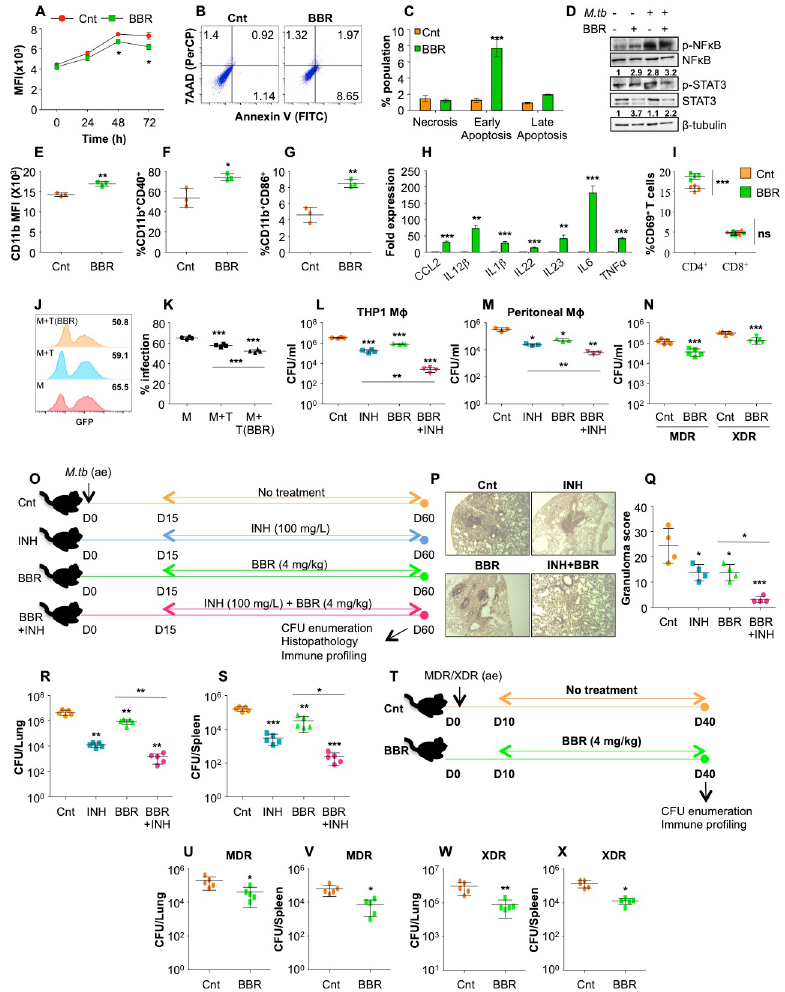
Fig 1. BBR treatment enhances host resistance against drug-sensitive and drug–resistant TB. (A) Mouse peritoneal macrophages were infected with GFP expressing H37Rv (Rv-GFP) at 1:10 MOI followed by treatment with BBR (20 μ g/ml). At different time points, cells were analysed by flow cytometry. Graph represents the GFP fluorescence at indicated time points with and without BBR treatment. (B-C) Mouse peritoneal macrophages were infected with M . tb at MOI of 1:10 followed by treatment with BBR (20 μ g/ml) for 48 h followed by apoptosis analysis via flow cytometry. (B) Representative dot plots and (C) Percentage of apoptotic cells with and without BBR (20 μ g/ml) treatment. (D) Immunoblots depicting the phosphorylation of indicated transcription factors (NFkB and STAT3) in uninfected and infected mouse peritoneal macrophages with or without BBR treatment. (E-G) Infected murine peritoneal macrophages were surface stained with antibodies against CD11b (APC/Cy7), CD40 (PE) and CD86 (PerCPCy5.5) followed by flow cytometry. (E) Expression of CD11b on the surface of infected macrophages. Percentage of (F) CD11b + CD40 + and (G) CD11b + CD86 + infected macrophages with and without BBR treatment. (H) Expression of chemokines and cytokines in M . tb infected macrophages at 24h pi with and without BBR (20 μ g/ml) treatment. (I) Percentage of CD4 + and CD8 + T cells expressing CD69 in the infected and BBR (10 μ g/ml) treated splenocytes. (J) Representative overlay plots and (K) percentage of RvGFP infected macrophages co-cultured with M . tb specific and BBR treated splenocytes. (L) PMA- activated THP1 macrophages were infected with H37Rv at 1:10 MOI followed by treatment with INH (1 μ g/ml), BBR (20 μ g/ml) or both for 48 h pi after which cells were lysed for CFU enumeration. (M) Experiment L was repeated in mouse peritoneal macrophages. (N) Mouse peritoneal macrophages were infected with MDR (Jal 2261) and XDR (MYC431) clinical strains of M . tb followed by treatment with 20 μ g/ml of BBR. Cell lysates were plated for CFU enumeration 48 h pi. (O) Schematic representation of the murine model of infection. C57BL/6 mice were infected with low dose of H37Rv (~110 CFU per lung) and after 15 days of disease establishment, mice were treated with either INH (100 mg/L), BBR (4 mg/kg) or both for 45 days followed by CFU enumeration and immune profiling. (P) Histopathology of infected lungs with arrows indicating the granulomatous lesions. (Q) Immunopathology score of the infected lungs. Bacterial burden in the (R) lungs and the (S) spleen of infected animals. (T) Diagrammatic representation of the infection model. Bacterial burden in (U) the lungs and (V) the spleen of